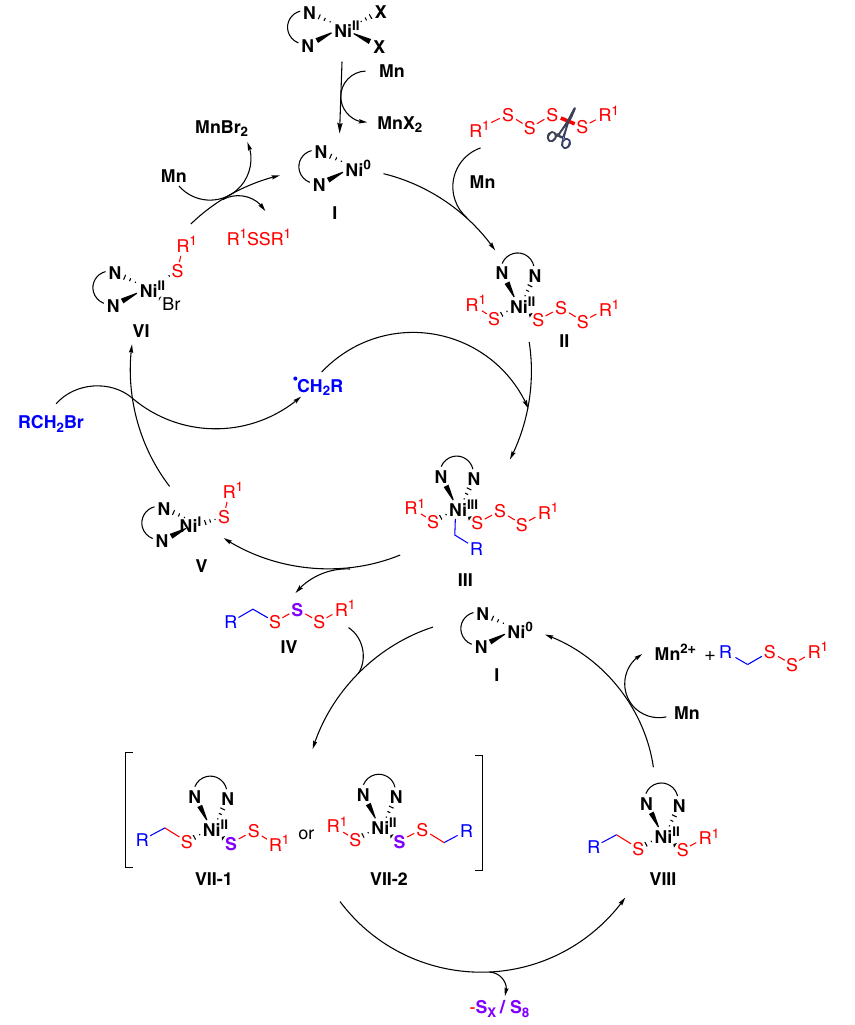
Fig. 9 Plausible catalytic cycle. Possible reaction mechanism for nickel-catalyzed reduction of disul fi de.